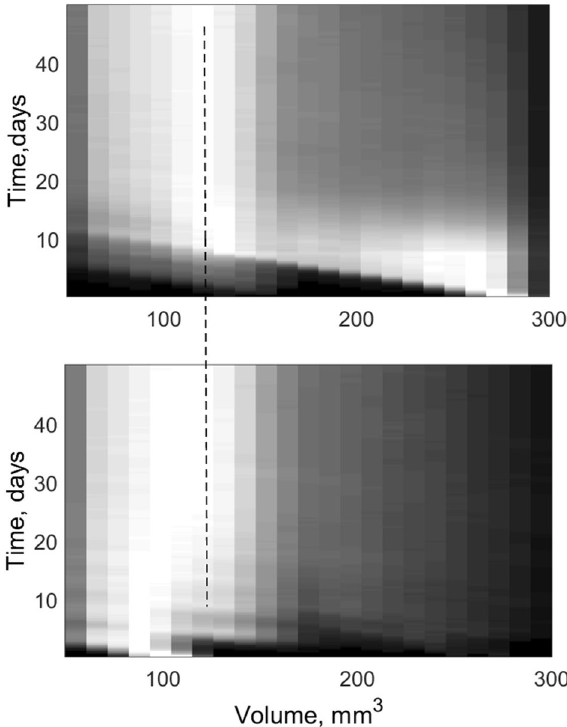
Figure 5. Gray-scale maps of time-volume histograms accumulated for two limit cases: starting from large and small animals, are shown in the subplots ( a , b ) respectively. Lighter gray color corresponds to the higher density. Dashed line marks common position of distribution maximums to which they converge during extremely long runs.